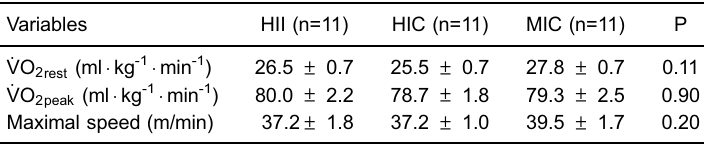
Table 3. Oxygen uptake at rest ( maximal speed attained during incremental exercise testing in the studied groups.